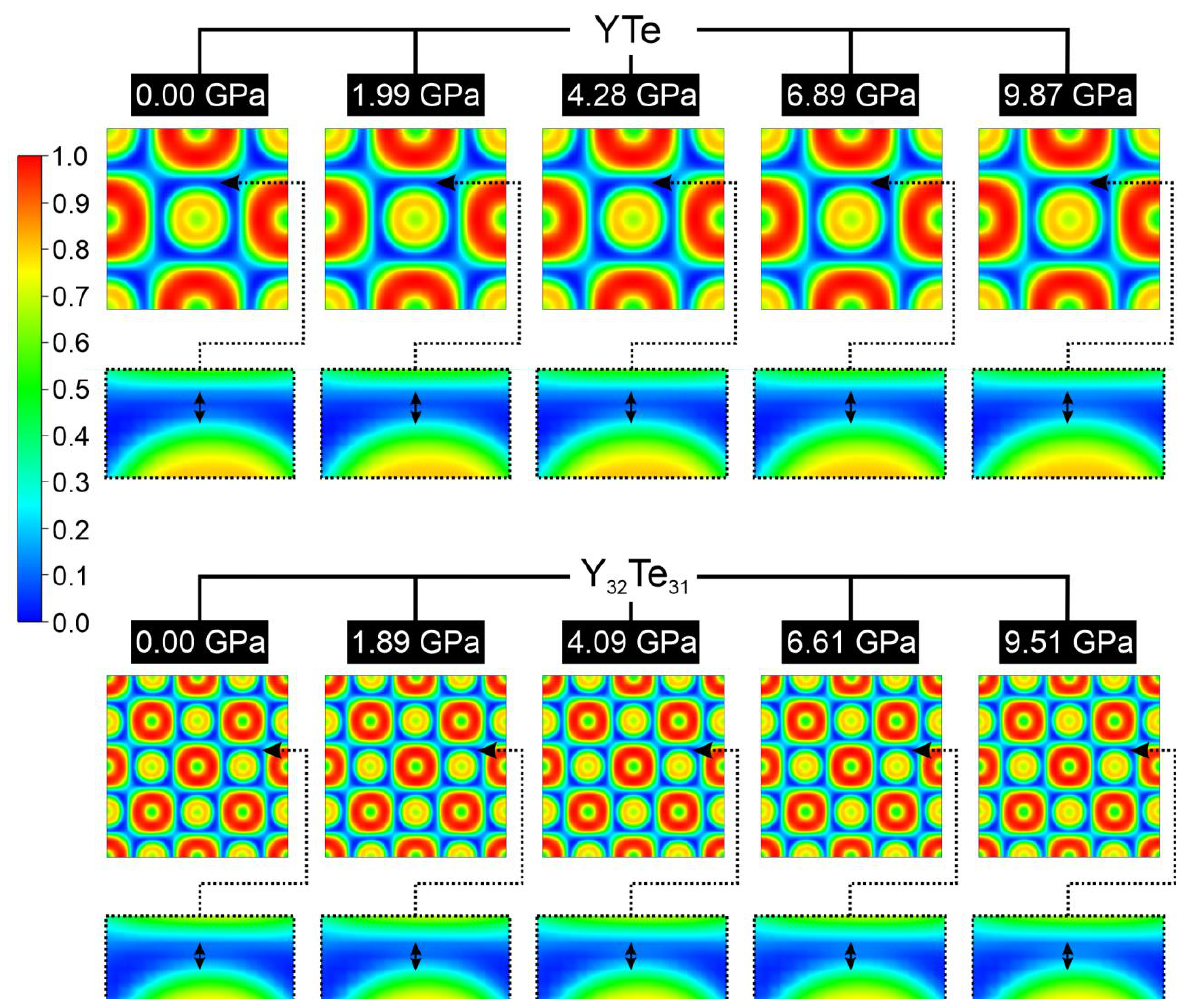
Figure 6. Representations of the electronic localization functions (ELFs) of the YTe ( top ) and the tellurium-deficient Y 32 Te 31 ( bottom ) with regard to the pressure. Magnified representations of sections of the respective ELFs are shown in the insets: the arrows have been included in order to highlight extremely small changes in the distances between certain domains.